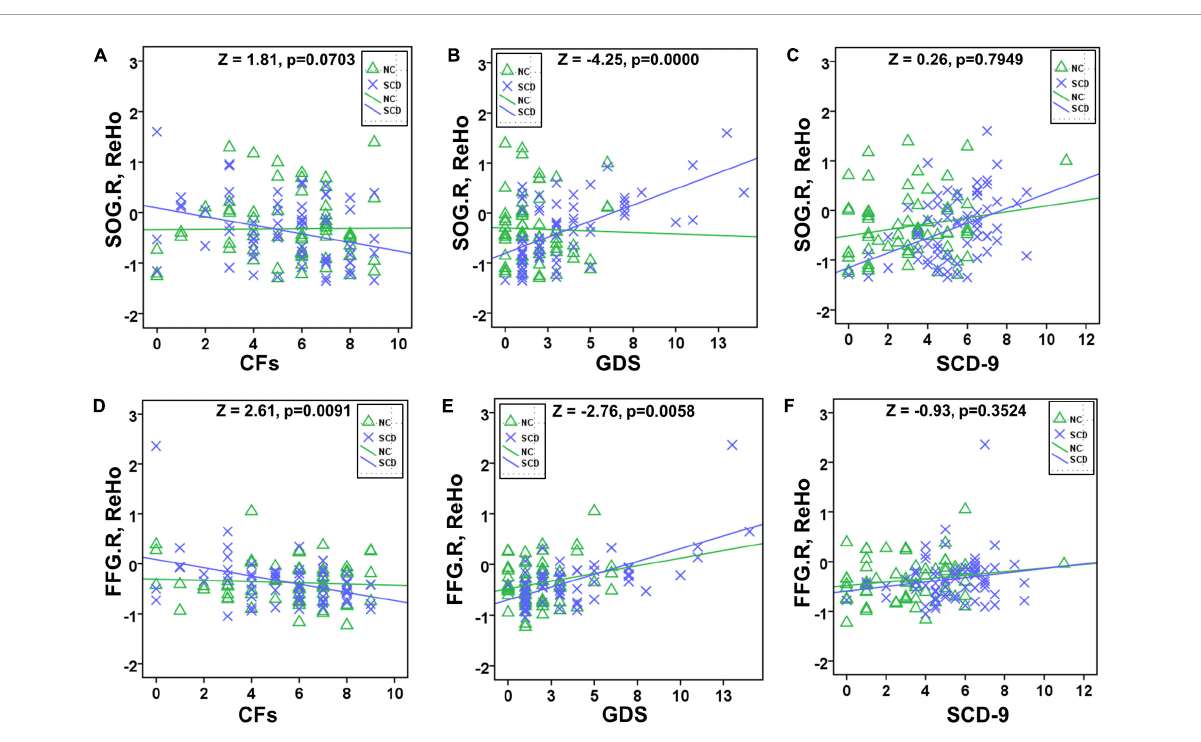
FIGURE3 Slope test between NC and SCD in SOG.R/FFG.R with CFs/GDS/SCD-9. Significant difference existed between NC and SCD in GDS–SOG.R (B) , CFs–FFG.R (D) , and GDS–FFG.R (E) . No significant difference existed between NC and SCD in CFs–SOG.R (A) , SCD-9–SOG.R (C) , and SCD-9–FFG.R (F)